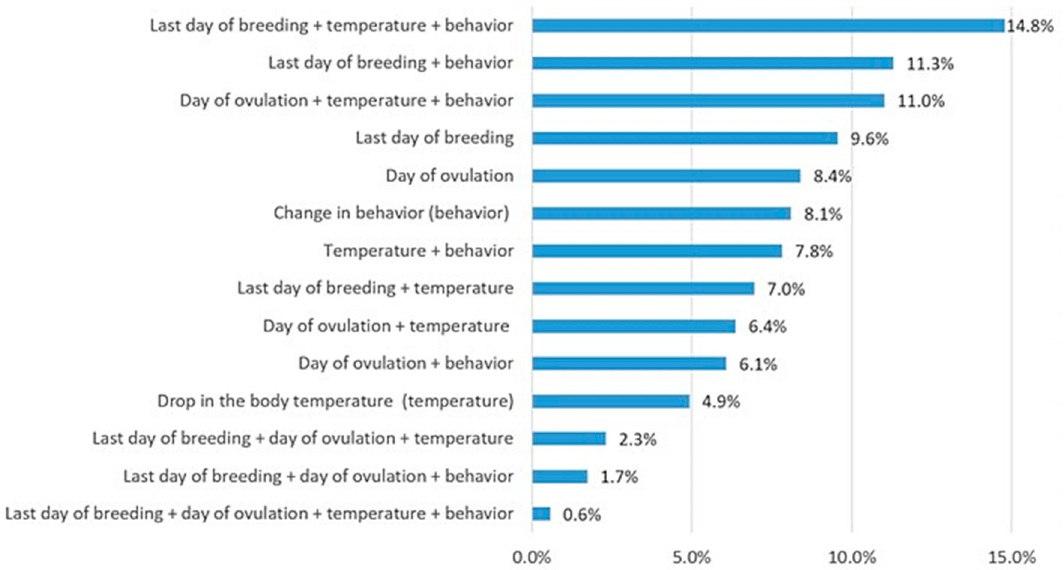
Figure 6. Methods used to estimate the whelping time of the bitch by using single or multiple information based on last breeding day, ovulation time, change in behavior and drop in the body temperature (multiple answers allowed).